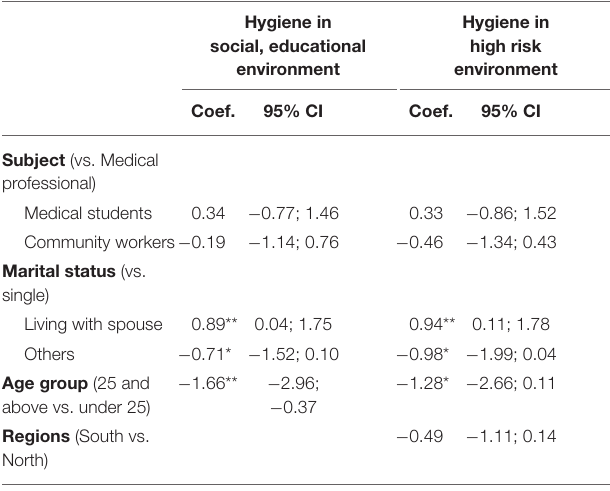
TABLE 4 | Factors associated with evaluating hygiene